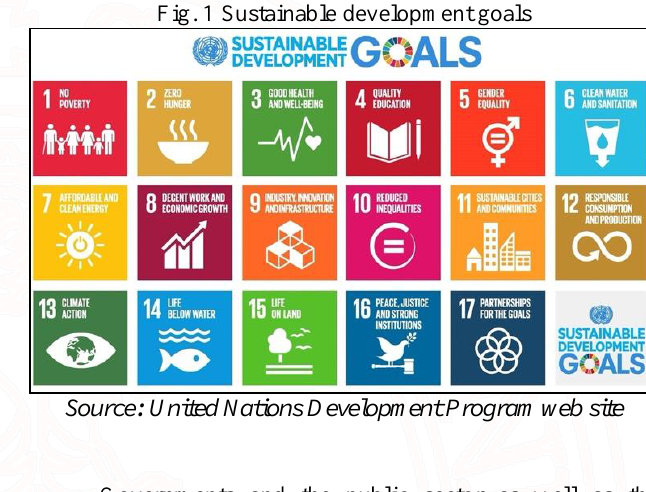
Fig. 1 Sustainable development